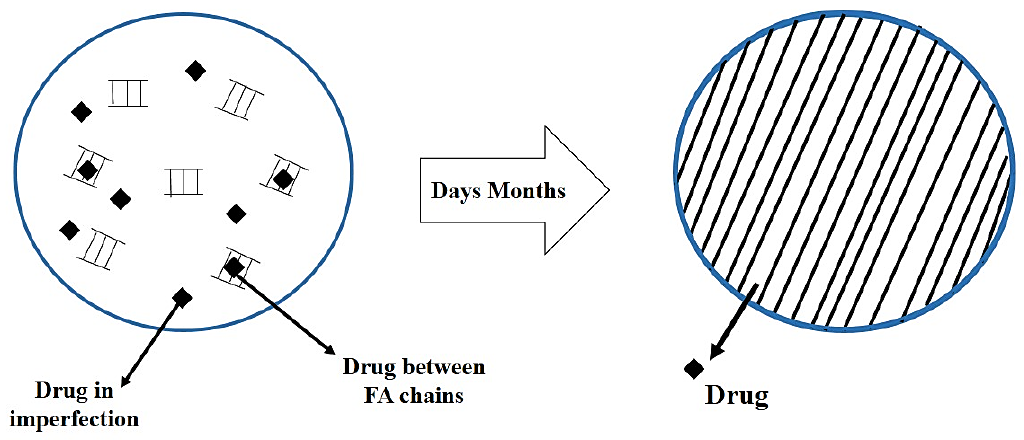
Fig. 5: Mechanism of drug excretion during storage from SLN, changing state to regular lipid crystal